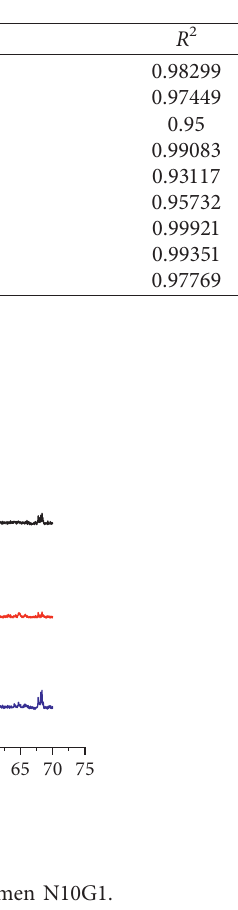
Table 4: Parameters and predicted life of the Weibull distribution model of each service condition under drying-wetting cycles and sodium sulfate